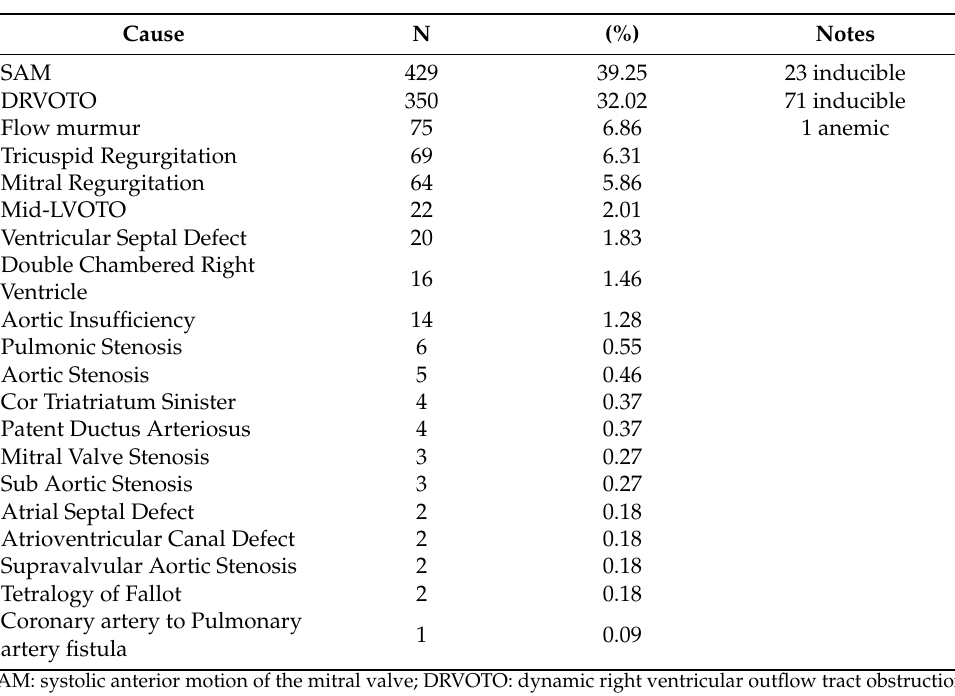
Table 2. Cause of the 1093 blood flow turbulences observed on echocardiographic study in 856 cats examined for investigation of heart murmur.